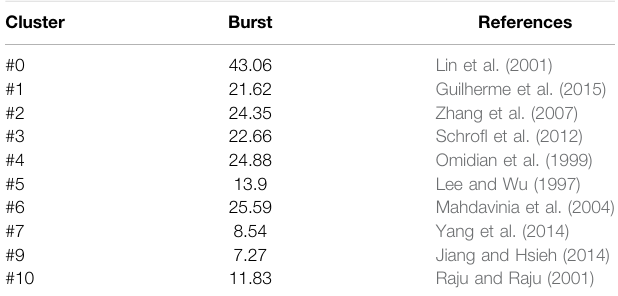
TABLE 5 | Articles with the strongest citation burst in the ten biggest clusters, respectively.